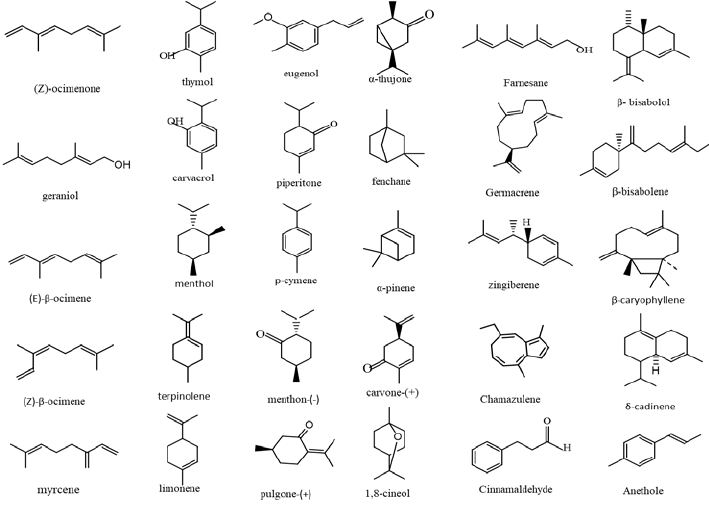
Figure 1. Chemical structures of the main essential oil constituents.